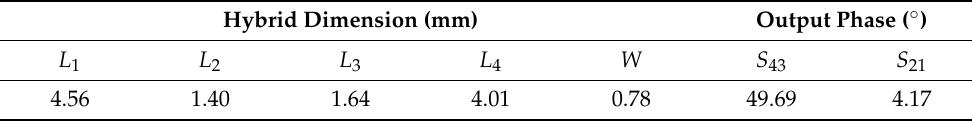
Figure 16b. The phase difference is calculated by S 43 (Phase) − S 21 (Phase) = ϕ 1 = ϕ 2 = 45° . Table 2. Via-hole with reference ‘ A ’ dimensions and output